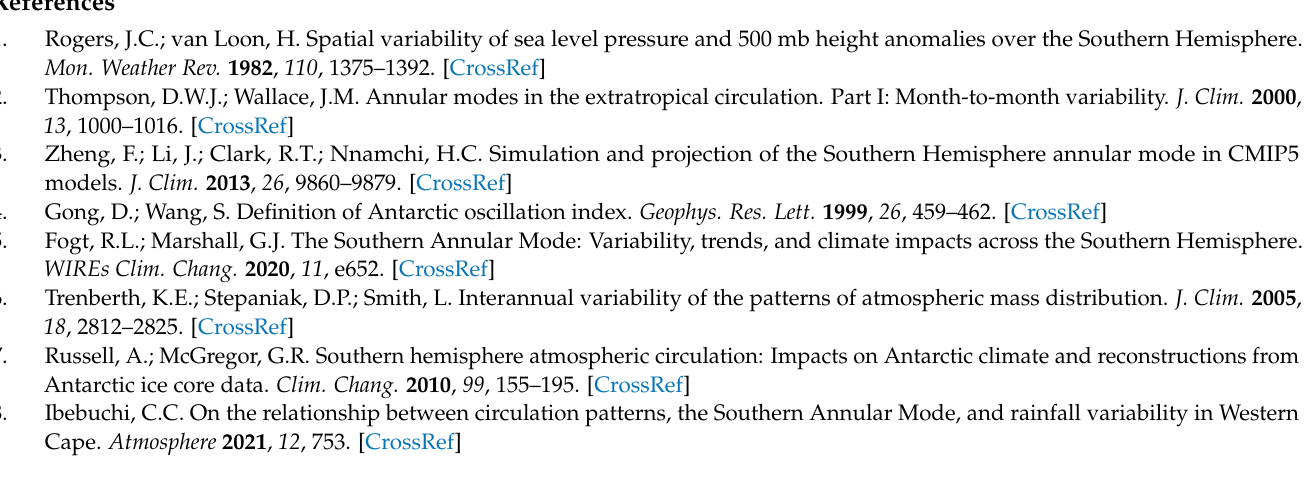
vational reconstruction fromthe Marshall index (Figure 1). Figure S2: DJF precipitation anomalies composites according to SAM phases. Figure S3: MAM precipitation anomalies composites accord- ing to SAM phases. Figure S4: JJA precipitation anomalies composites according to SAM phases. Figure S5: SON precipitation anomalies composites according to SAM phases. Figure S6: DJF surface temperature anomalies composites according to SAM phases. Figure S7: MAM surface temperature anomalies composites according to SAM phases. Figure S8: JJA surface temperature anomalies composites according to SAM phases. Figure S9: SON surface temperature anomalies composites according to SAM